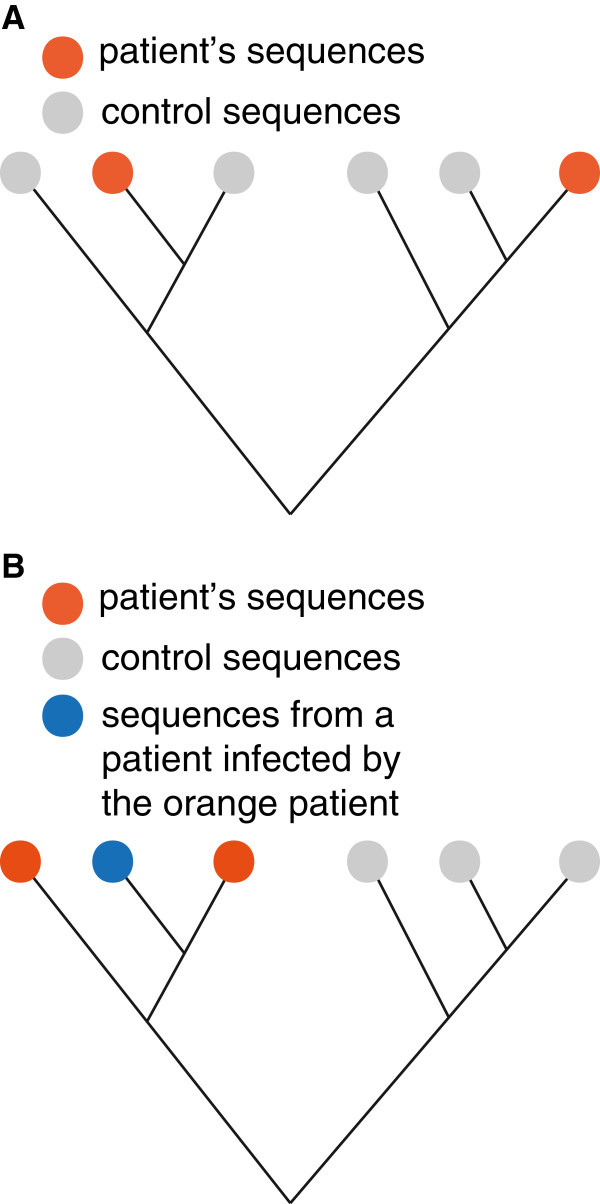
Scheme of phylogenetic trees representing superinfection or transmission cluster. Orange nodes denote sequences from the individual under examination; grey nodes represent control sequences. Panel A illustrates a case of superinfection, while Panel B illustrates a transmission cluster. The sequences of the patient under study fail to form a monophyletic cluster in both cases; however, the number of control sequences in the smallest subtree that includes the sequences of the patient tends to be much greater in the case of superinfection (see main text).